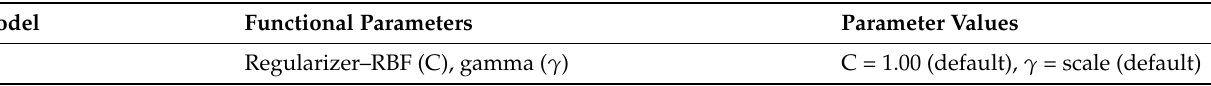
Table 4. SVC classification model and its